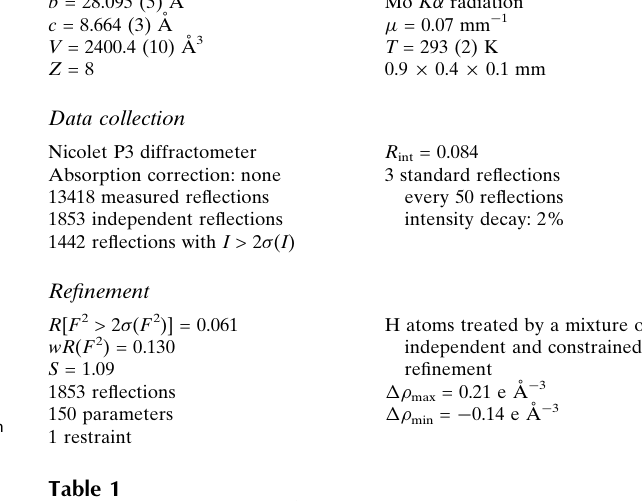
Hydrogen-bond geometry (A ˚ , (cid:2) ). X 1 is the midpoint of the alkynyl